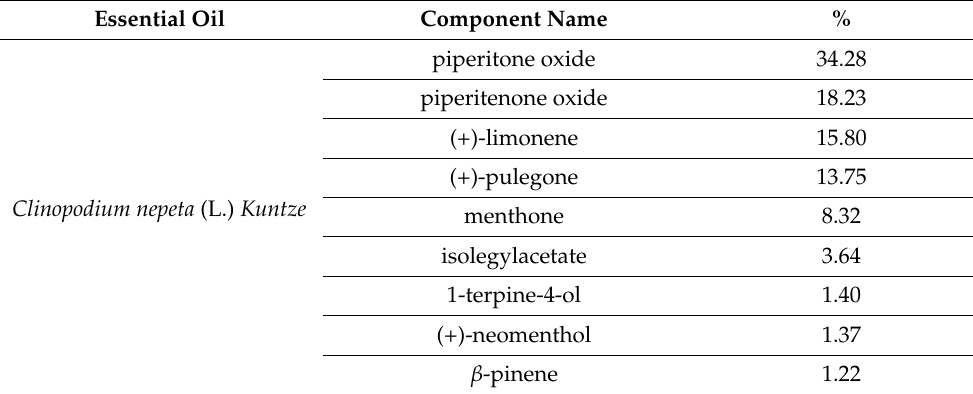
Table 2. List of the major components characterized by GC–MS in the essential oils (relative abun- dance ≥